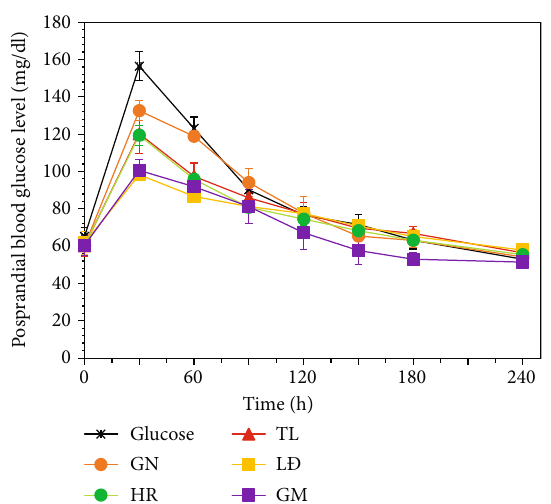
Figure 2: Postprandial blood glucose tolerance in